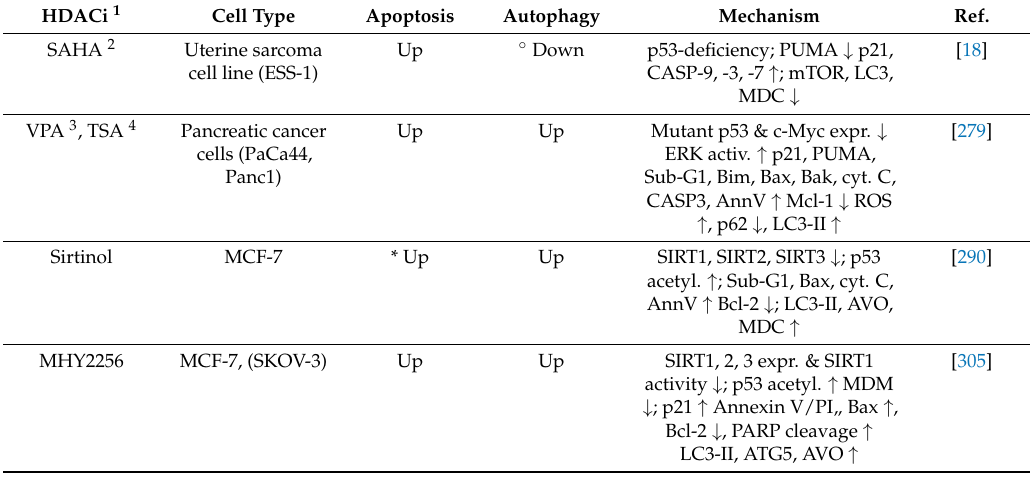
Table 1. Overview of histone deacetylase inhibitor-triggered apoptotic and autophagic cell